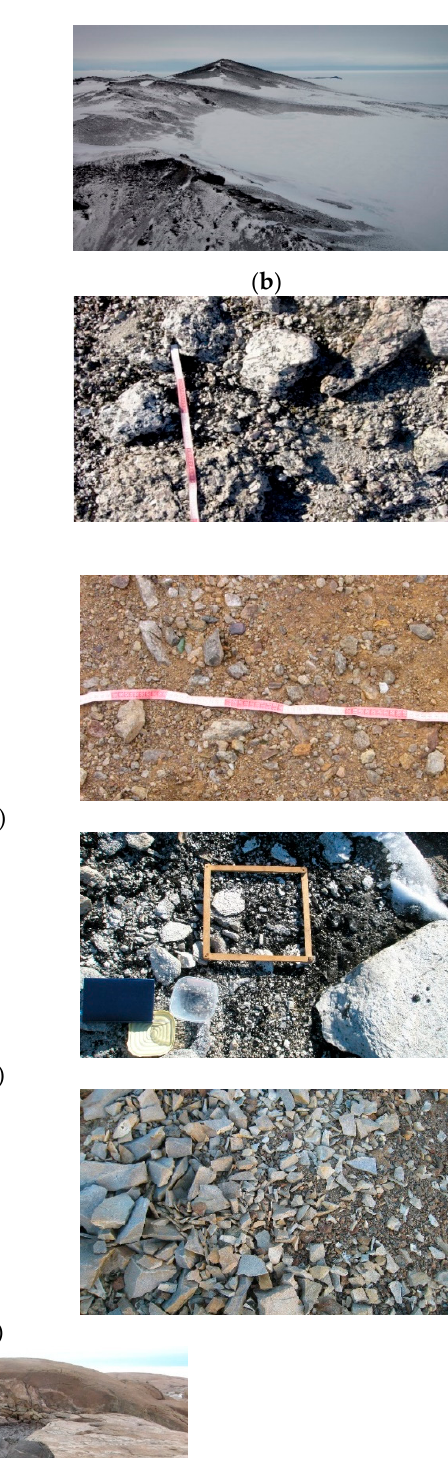
Figure 1. Localization of soil sampling sites in Antarctica: 1 —Bellingshausen Station, King George Island, 2 —Mirniy Station, 3 —the Haswell Archipelago, 4 —the Hudson Mountains, 5 —Druzhnaya 4 Station, 6 —Leningradskaya Station and 7 —Russkaya Station.